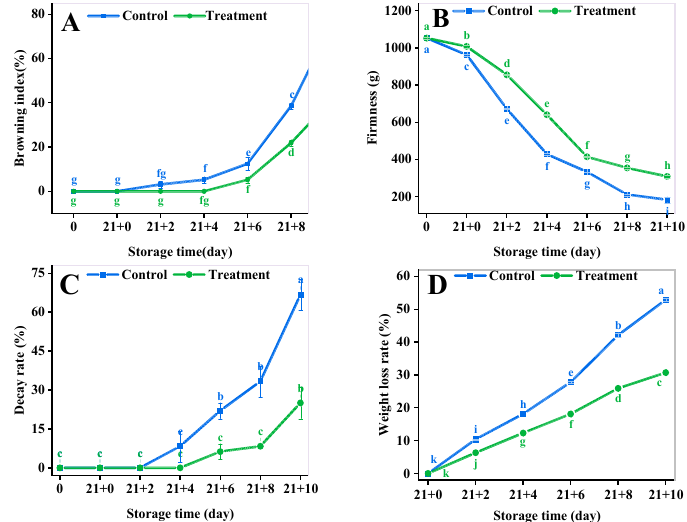
Figure 2. Effect of different storage methods on browning index ( A ), firmness ( B ), decay rate ( C ), and weight loss rate ( D ) of yellow peaches. Vertical bars represent standard deviations. Different letters represent statistical differences ( p < 0.05).